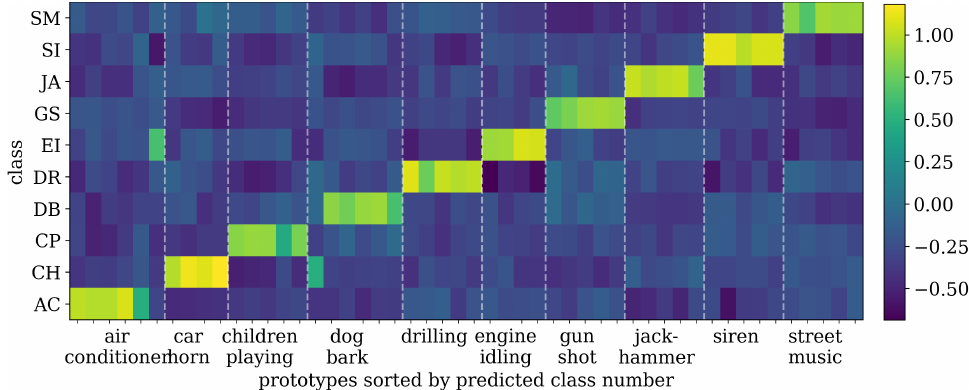
Figure 6. Transposed weight matrix of last fully-connected layer, W T